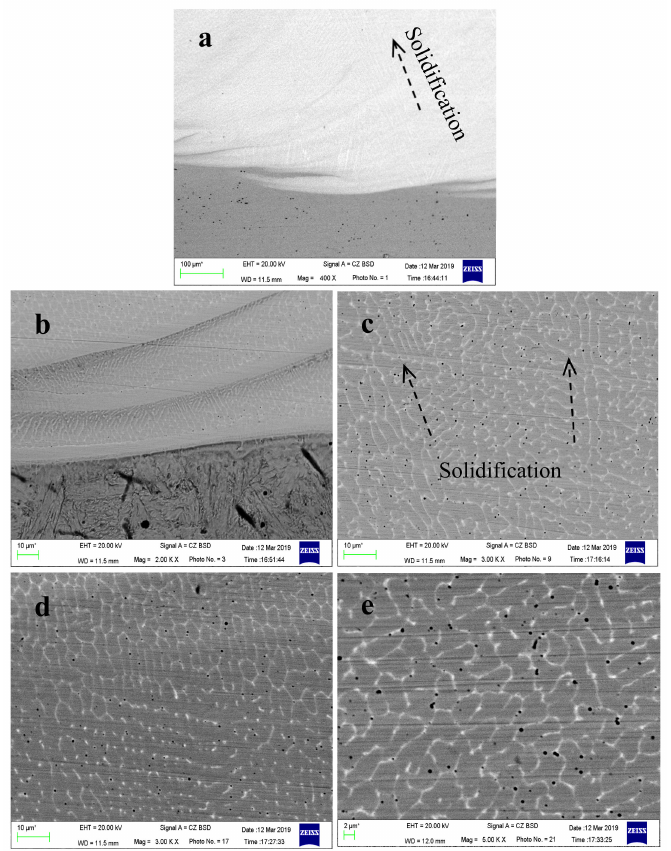
Figure 4. SEM images of ( a ) the bottom region at low magnification; ( b ) the bottom region at high magnification; ( c ) the middle region; ( d ) the top region at low magnification; and ( e ) the top region at high magnification of the laser cladding C22